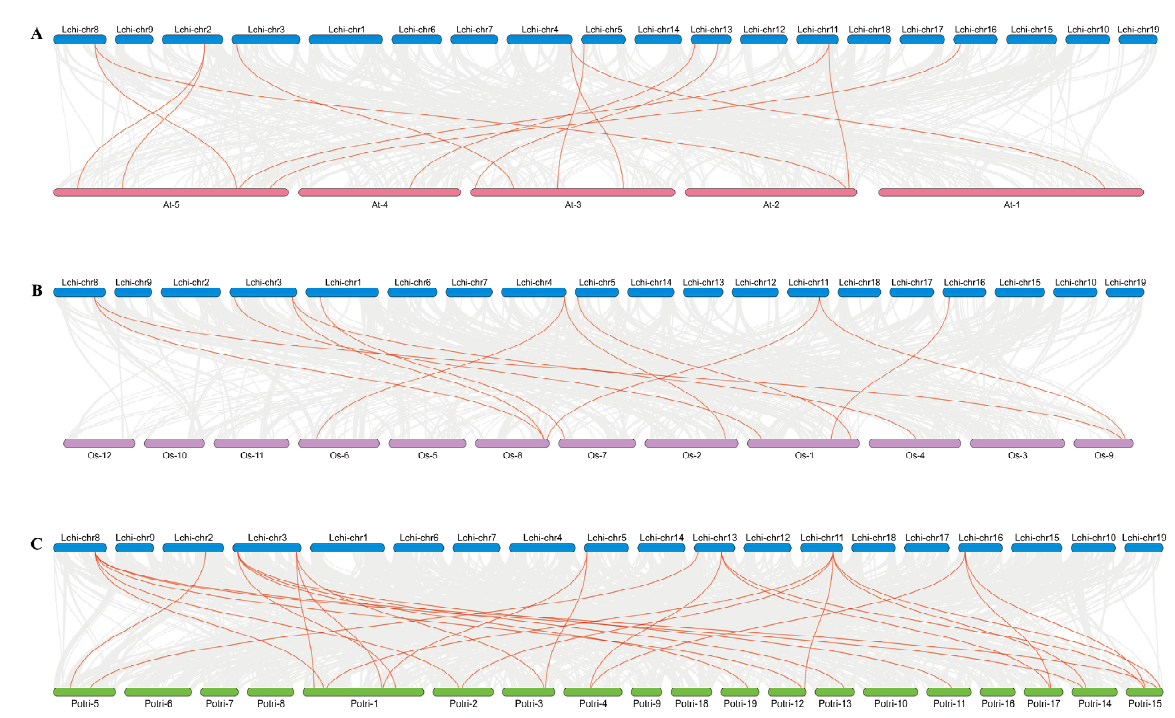
Figure 7. Genome-wide synteny analysis of LcTCP gene family among L. chinense and three other species. Red lines highlight the syntenic LcTCP gene pairs, while grey lines in the background indicate collinear blocks between; ( A ) L. chinense and A. thaliana , ( B ) L. chinense and O. sativa , ( C ) L. chinense and P. trichocarpa .